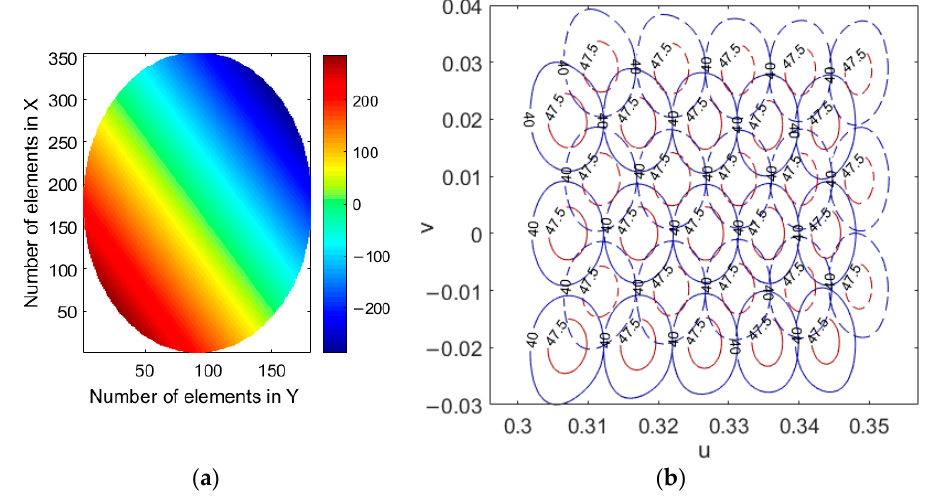
Figure 10. Design for dual polarization: ( a ) phase increment (in degrees) required with respect to the initial polarization and ( b ) pattern contours of 40 dBi and 47.5 dBi for the beams produced at 20 GHz by the bifocal DRAA, using solid lines for polarization 1 and dashed lines for polarization 2.